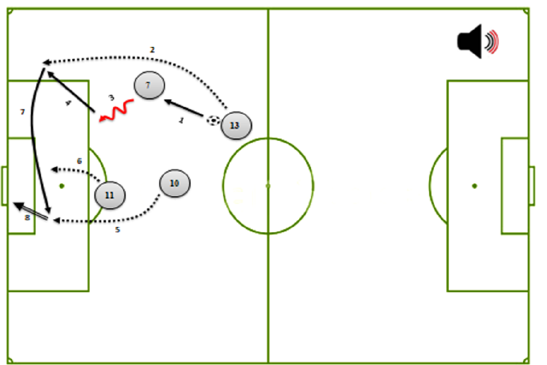
Figure 2. Simple multimedia material by coordinated dual (visual and verbal) cueing of the third game action.